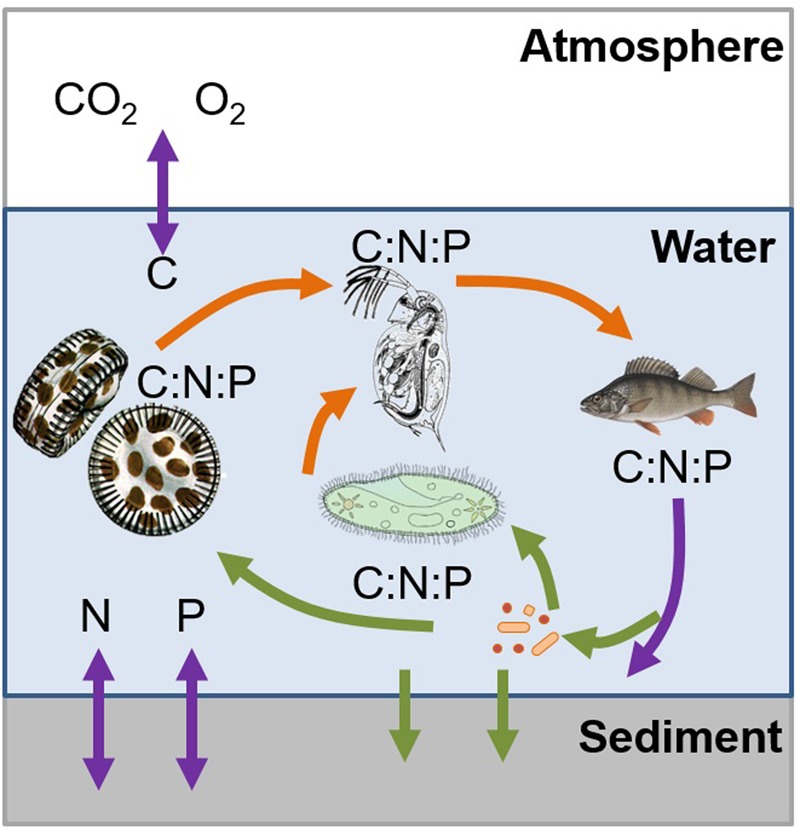
Example demonstrating how ecological stoichiometry can be used to link food web interactions, ecosystem metabolism, and biogeochemistry in a system, as they are inherently linked by the transfer of carbon, nitrogen, and phosphorous through biotic and abiotic nutrient transformation and fluxes. The trophic interactions (orange arrows) are occurring based on the nutrient requirements which are limited by the available nutrients (green arrows) as they are transferred and transformed (purple arrows) between the atmosphere, water column, and sediment. The colors of arrows indicate the processes described in Figure 1.